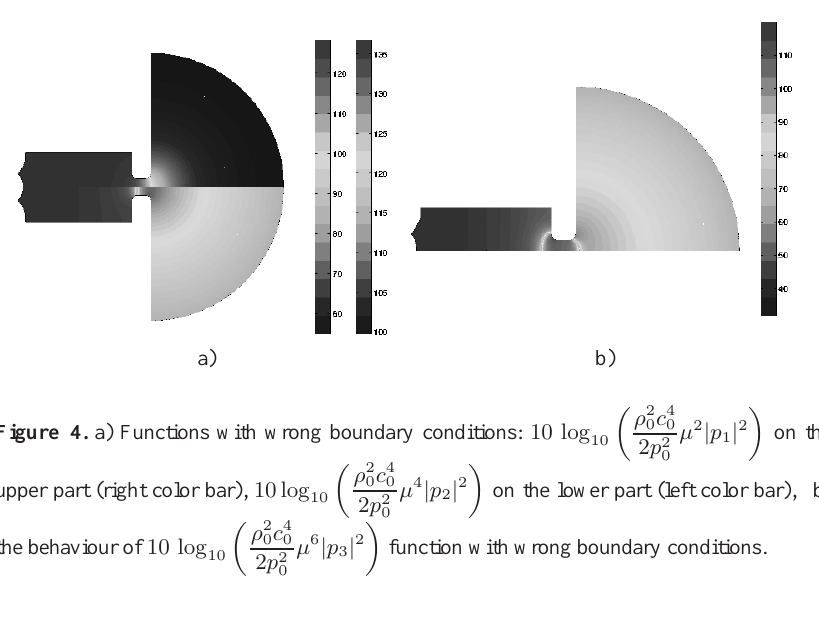
ρ 2 0 c 4 0 µ 4 | p 2 | 2 on the lower part (left color bar), b) 2 p 2 0 « „ ρ 2 0 c 4 0 µ 6 | p 3 | 2 function with wrong boundary 2 p 2 0 „ «